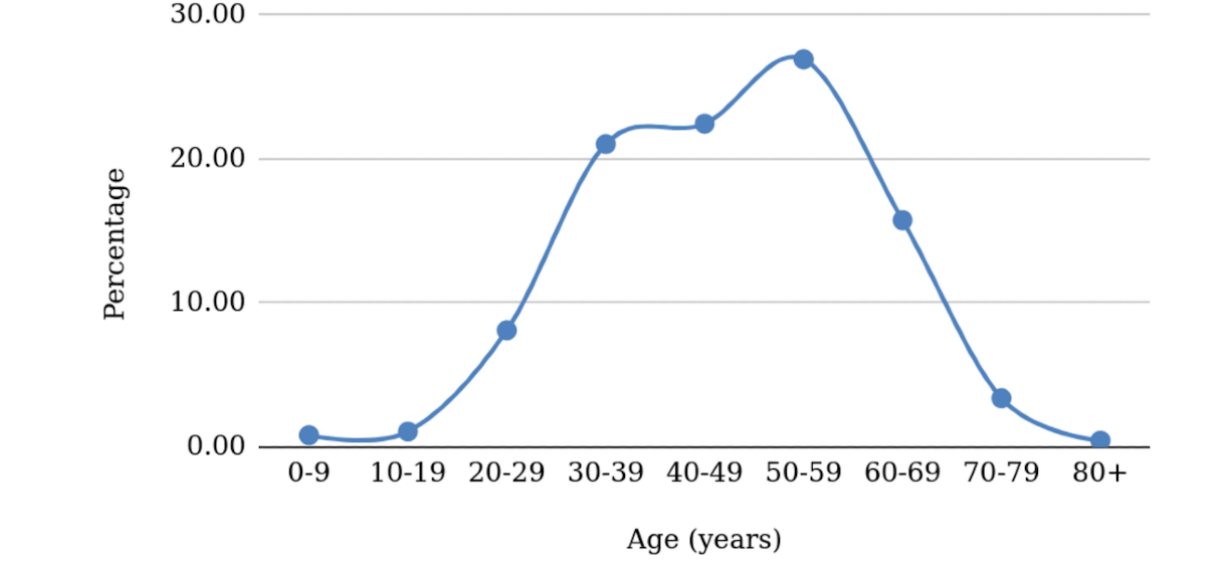
Figure 1. Projected age-stratified percentages of cases for